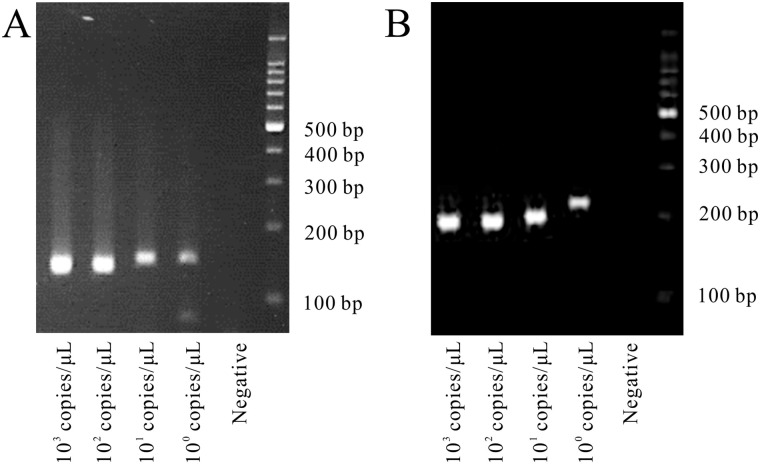
RT-PCR electrophoresis for the confirmation of the detection limit.(A) Primer 2. Viral RNA was extracted from the SPL010 strain. 103−100 copies/reaction and mock sample (from left to right). A PCR product of 125 bp was observed. (B) Primer 4. Viral RNA was extracted from HB29 strain. 103−100 copies/reaction and mock sample (from left to right). A PCR product of 179 bp was observed.